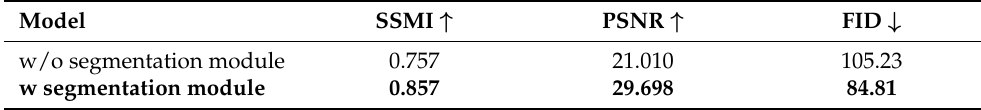
Table 3. Comparison of the influence of segmentation module in ColorMedGAN.